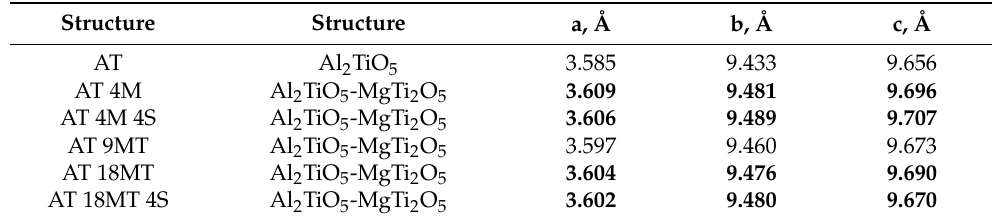
Table 5. Lattice parameters of Al 2 TiO 5 on the basis of averages of experimental data from Figures 2 and 3 (sintering temperature 1350 ◦